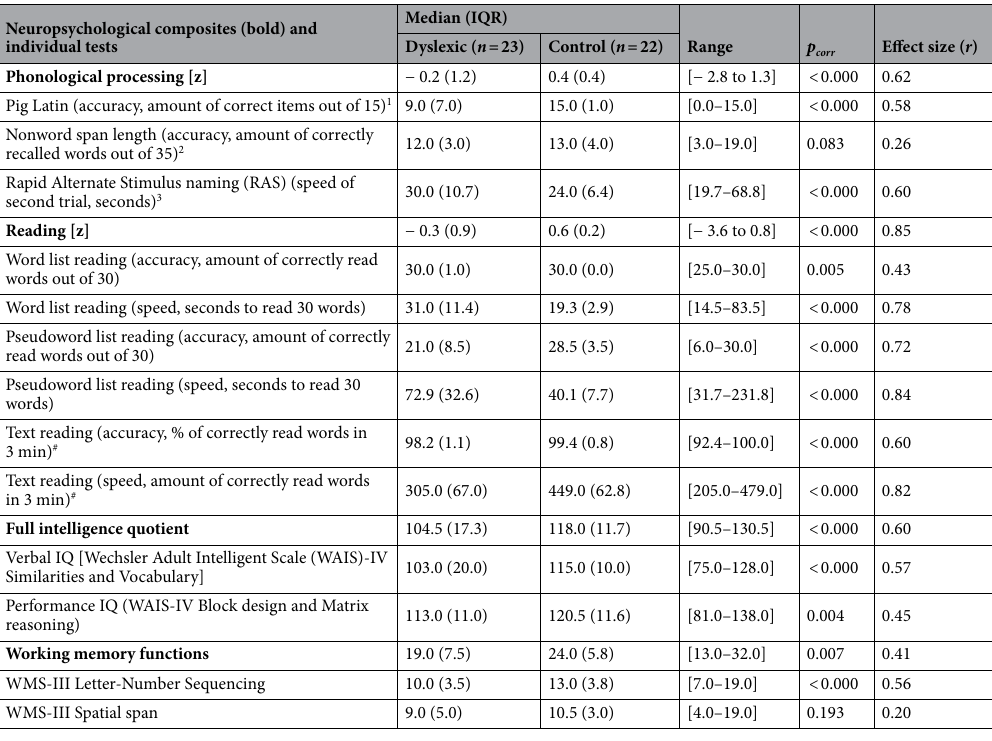
Table 2. Neuropsychological data. Notes. Group sizes (n) and median values of all variables in the Dyslexic and Control groups with interquartile range (IQR) in parentheses. Group differences were tested with Wilcoxon sign-rank test, p-values are FDR-corrected, and effect sizes (r) are Wilcoxon Effect Sizes. Composite scores of the test results (bolded) were formed for phonological processing and technical reading by converting the raw scores (of subtests below the respective composite) to z-scores and averaging them, and for working memory according to WMS-III (Wechsler, 2008). For all IQ scores, normalized mean = 100 and SD = 15. For WMS-III subtests, normalized mean = 10 and SD = 3. For WMS-III working memory index, normalized mean = 20 and SD = 6. 1 Phonological awareness. 2 Phonological short-term memory. 3 Rapid serial naming. # Not included in the reading composite